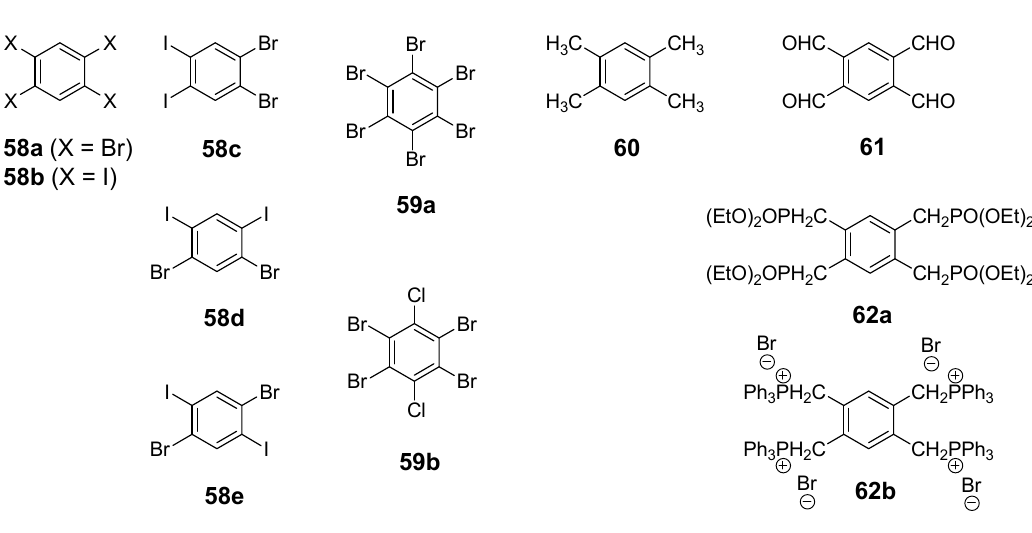
19. Core building blocks for the synthesis of various tetra-substituted conjugated